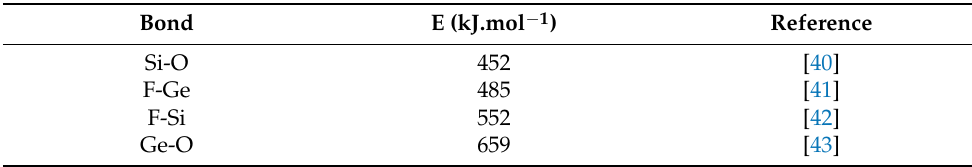
Table 10. The main bond